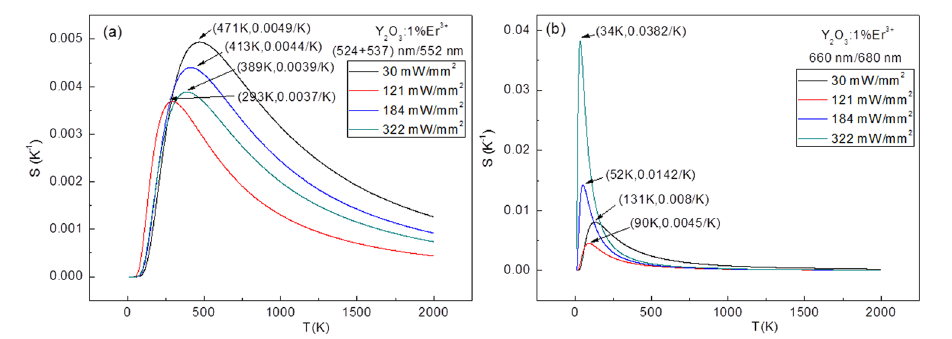
Figure 13. Excitation powers dependent sensitivity of Y 2 O 3 :1%Er 3 +